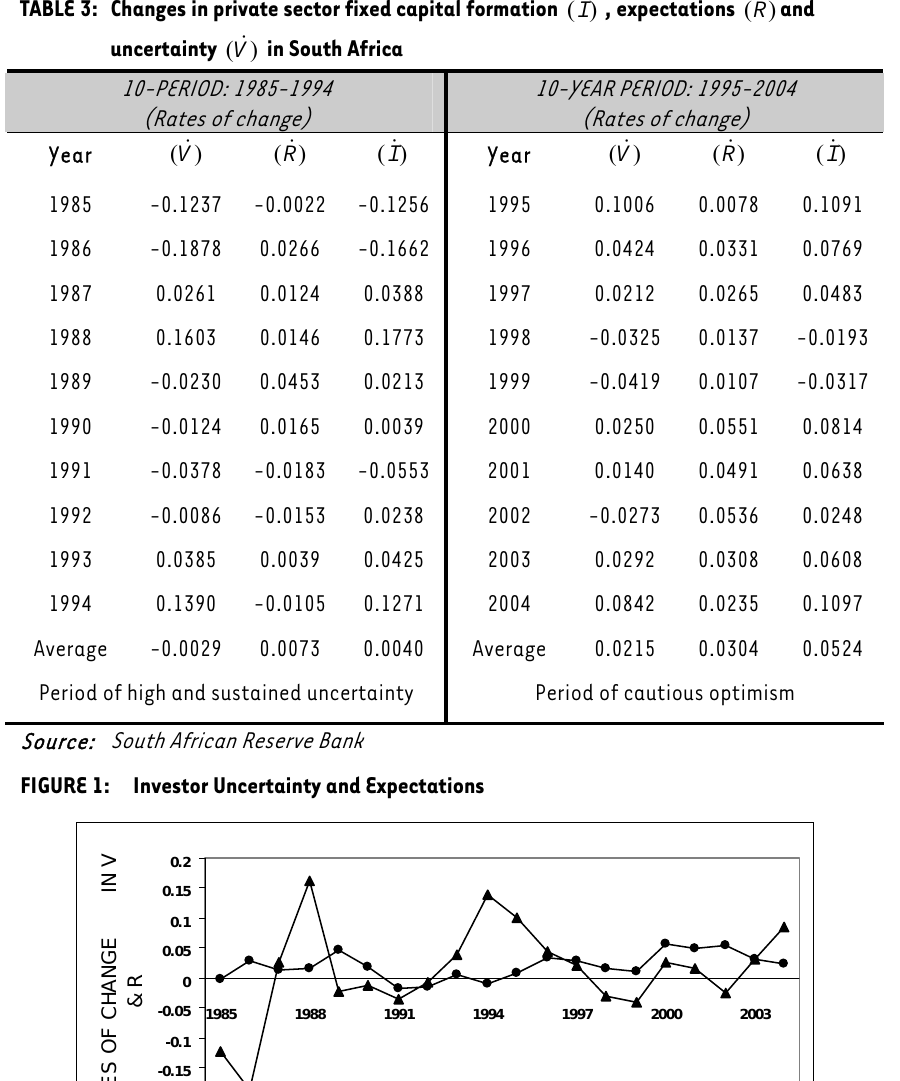
TABLE 3: Changes in private sector fixed capital formation )( I & , expectations )( R & and